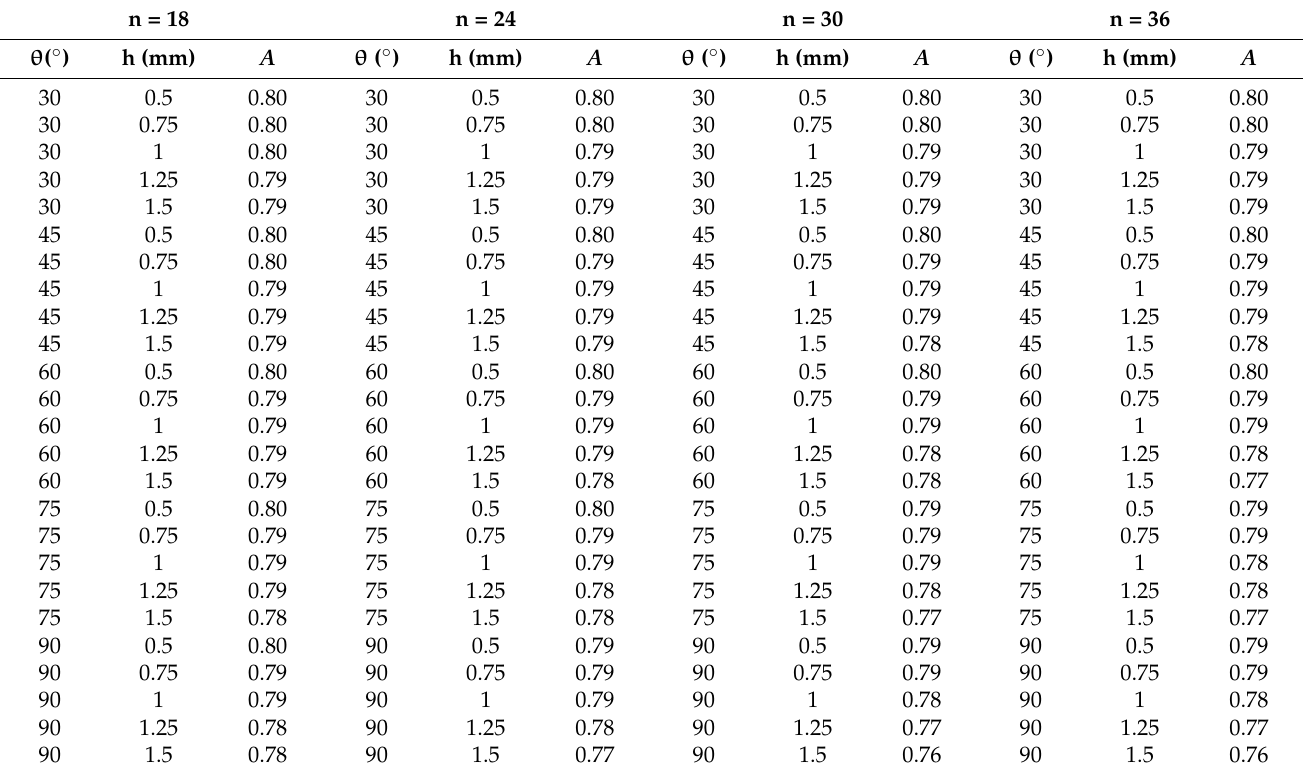
Table 1. Cross-sectional area ratios of inlet and outlet under different size parameters ( θ is top angle, h is texture height, n is the number of circumferential columns, and A is A in / A out